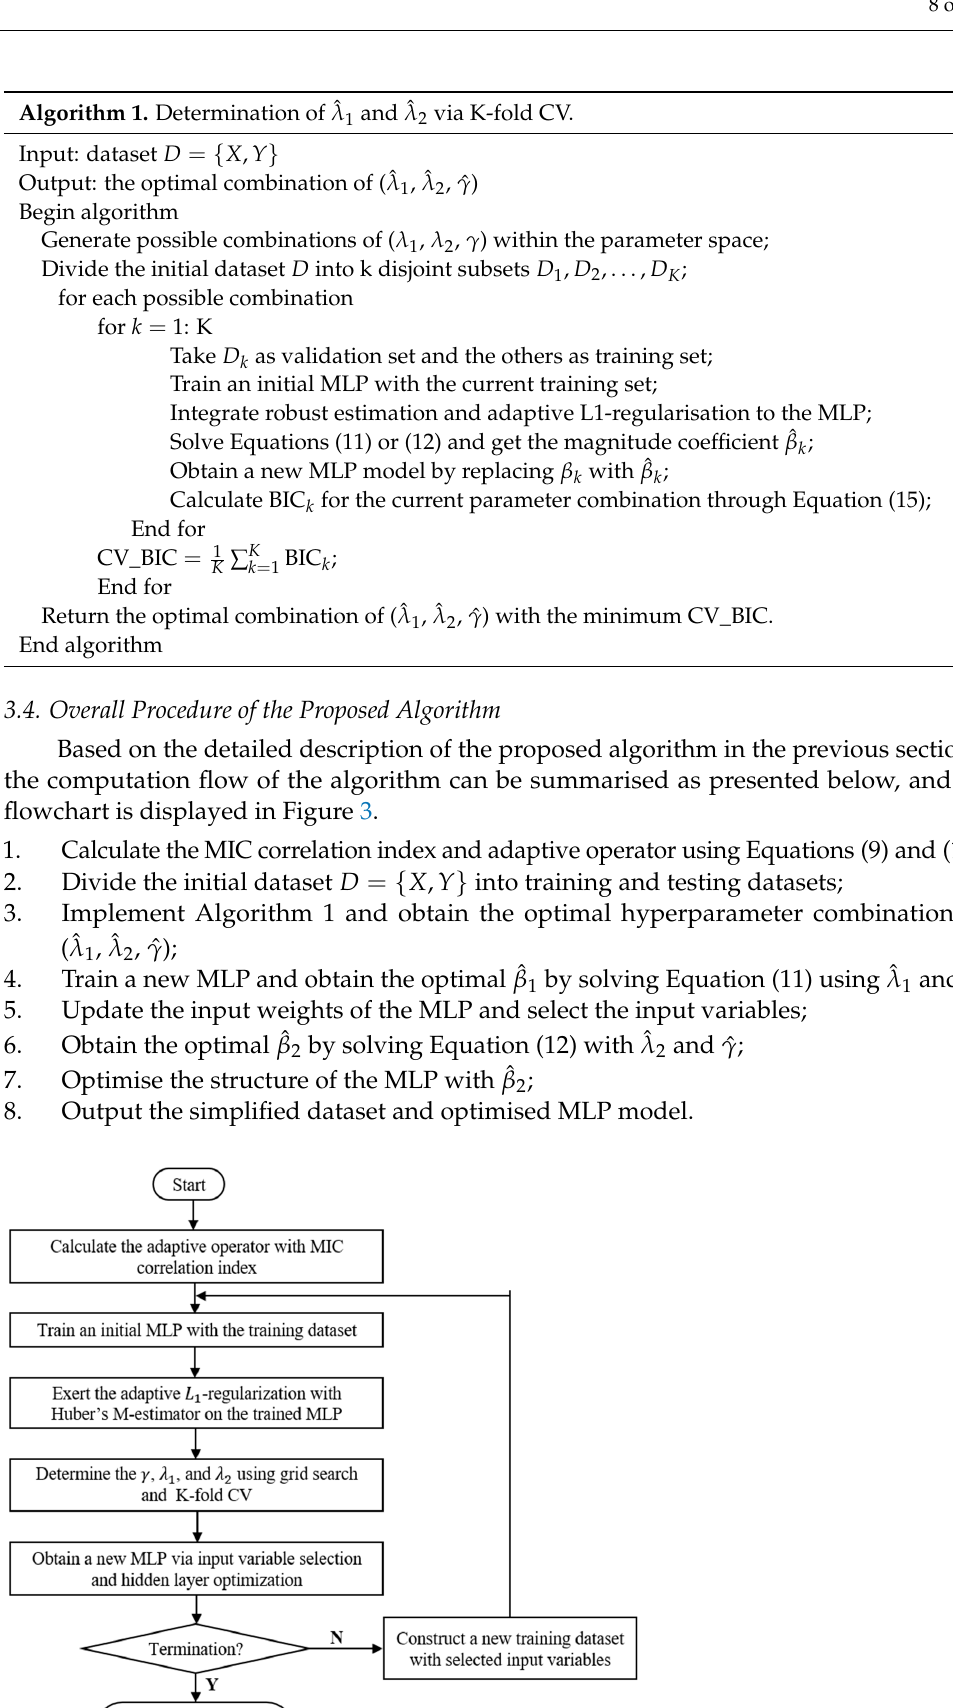
Algorithm 1. Determination of ˆ λ 1 and ˆ λ 2 via K-fold CV.